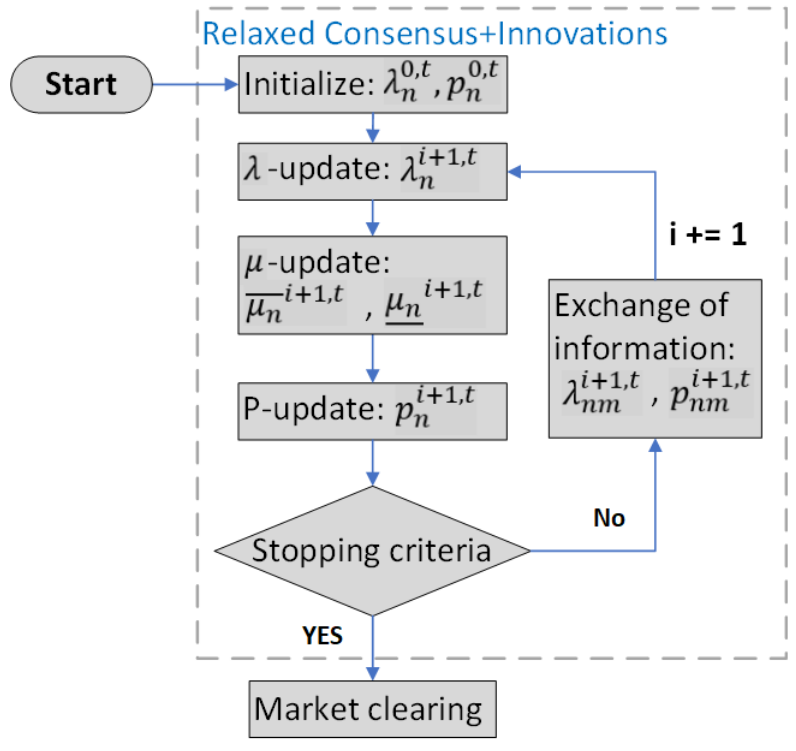
Figure 2. Diagram of the Relaxed Consensus + Innovations